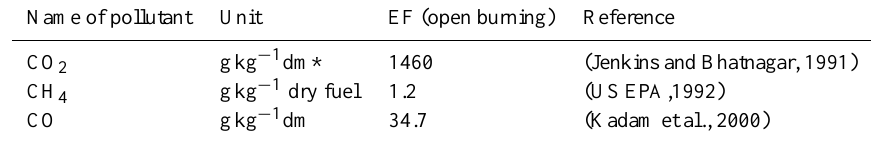
Table 3. The exhaust gases from the open burning of rice straw associated with carbon emissions (Gaddle et al., 2009).